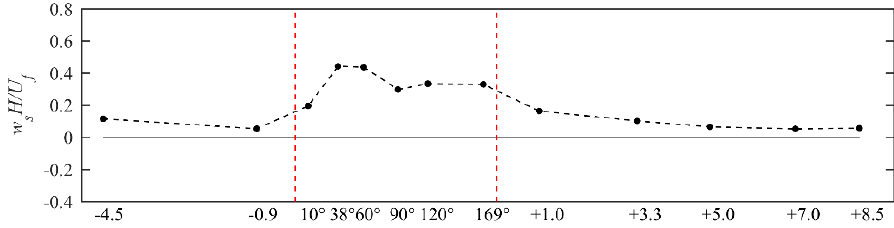
Figure 8. Evolution of dimensionless secondary flow strength.